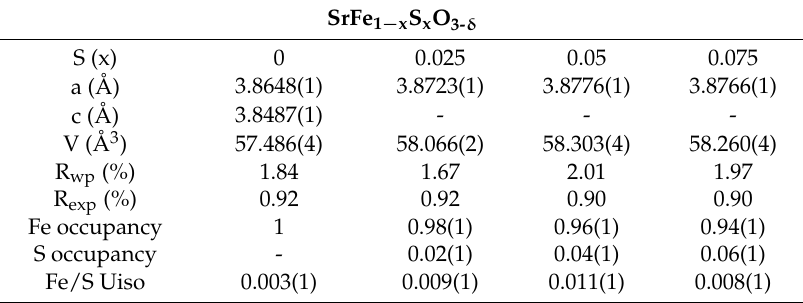
Table 1. Lattice parameters and Fe/S site occupancies obtained from Rietveld refinement using XRD data for SrFe 1 − x S x O 3- δ . The structure of SrFeO 3- δ was refined using a tetragonal space group (P4/mmm). The structures of the sulfate-doped samples were refined using a cubic space group